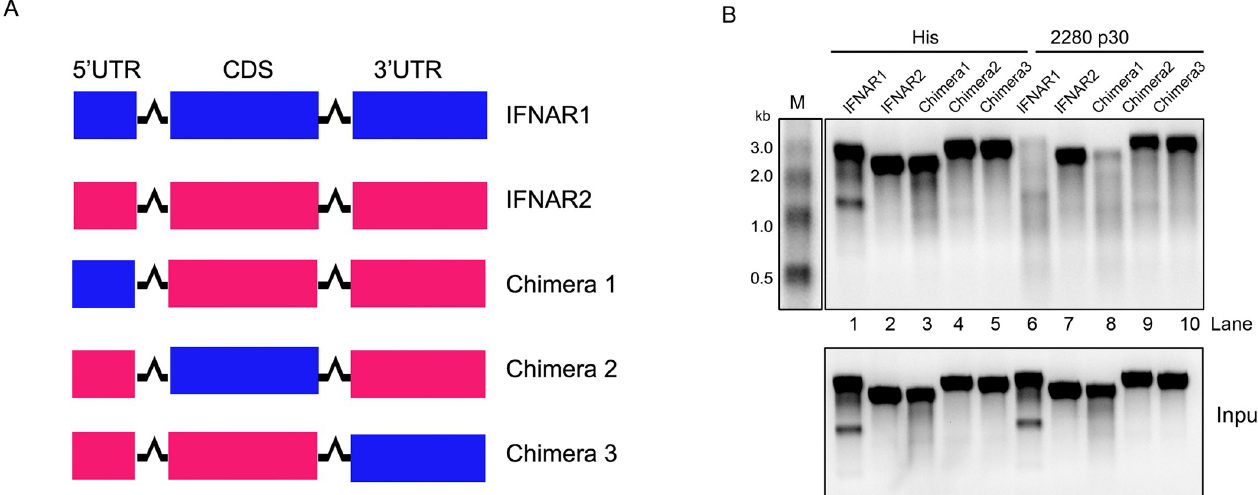
Fig 6. The 5’UTR of IFNAR1 confers selective degradation. (A) Schematic ofchimeric IFNAR2 fused with the 5’UTR, the coding sequence (CDS), or the 3’UTR of IFNAR1. (B) His (10 μ g) or His-2280 p30 fusion protein (10 μ g) were incubated at 30˚C with 4 μ g of IFNAR1 or IFNAR2 RNA or chimeric IFNAR2 transcribed in vitro . After 60 min of incubation, the RNA was purified and resolved on an agarose-formaldehyde gel. The gel electrophoresis result is representative of three independent experiments.